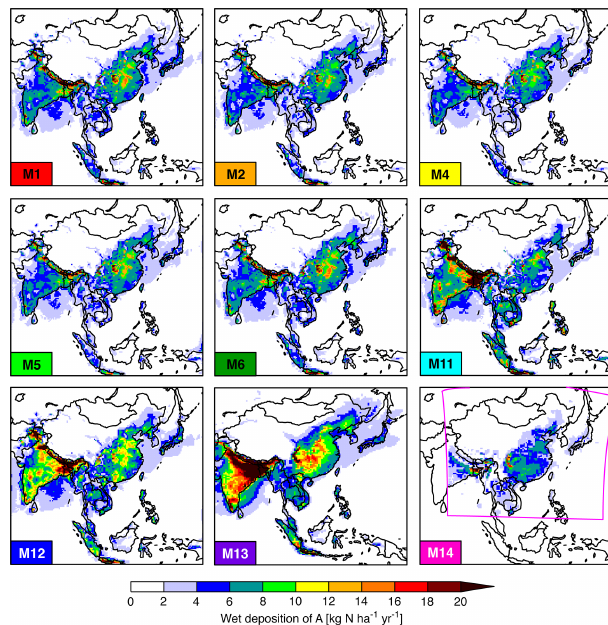
Figure 8. Spatial distributions of the annual accumulated wet depo- sition of